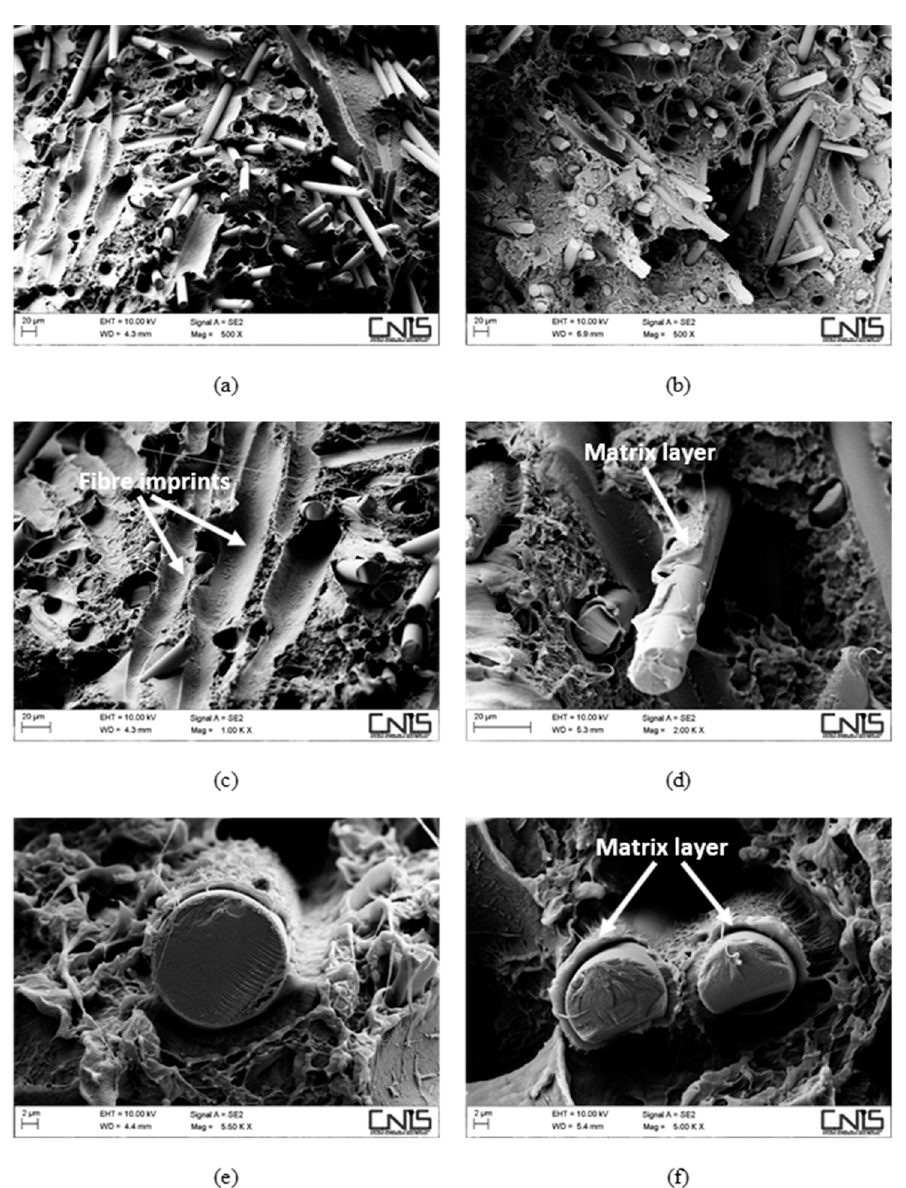
Figure 7. SEM micrographs detailing the fracture surface of aged composites, reinforced with 30 wt % of basalt fibres without ( a , c , e ) and with ( b , d , f ) a coupling agent.